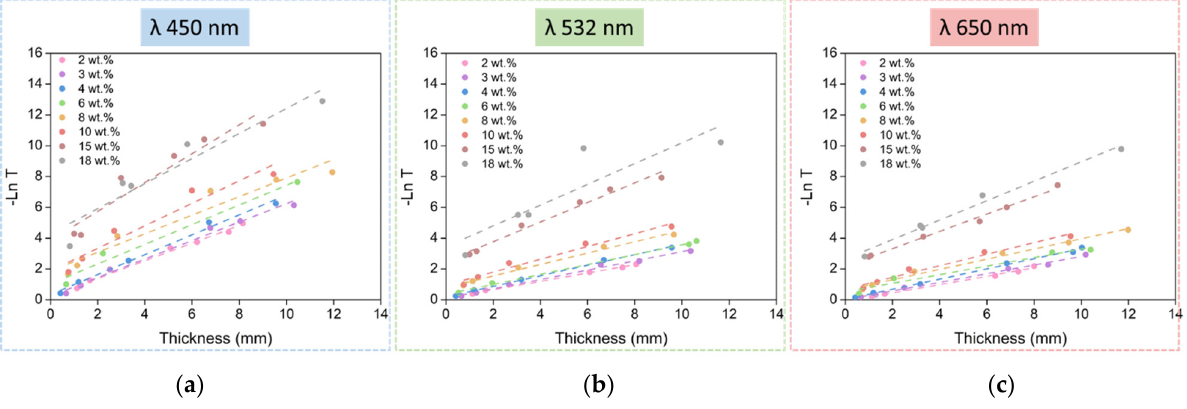
Figure 4 . − ln(T) vs. thickness for all the aerogel samples understudy at three different laser wave- lengths, ( a ) λ = 450 nm; ( b ) λ = 532 nm and ( c ) λ = 650 nm.